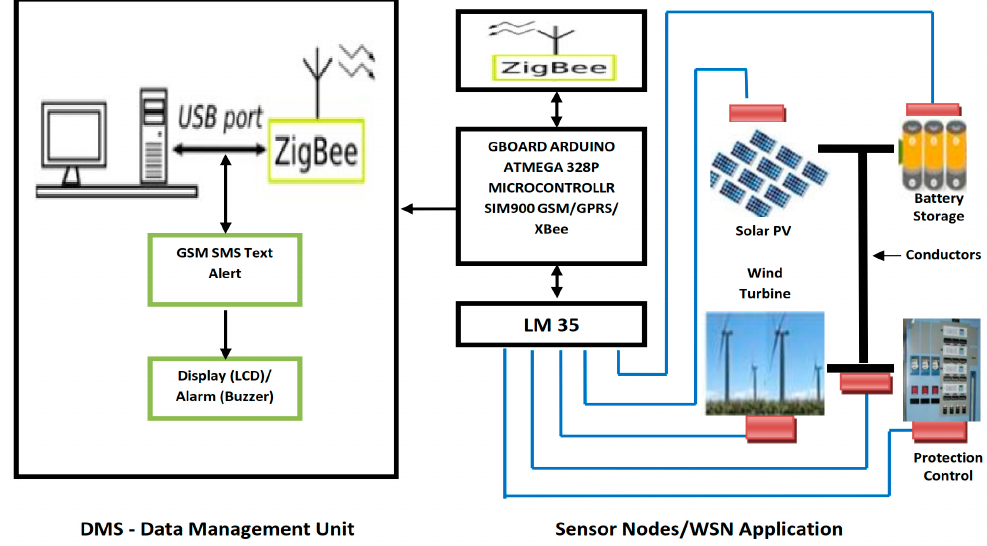
Figure 3. System architectural illustration.